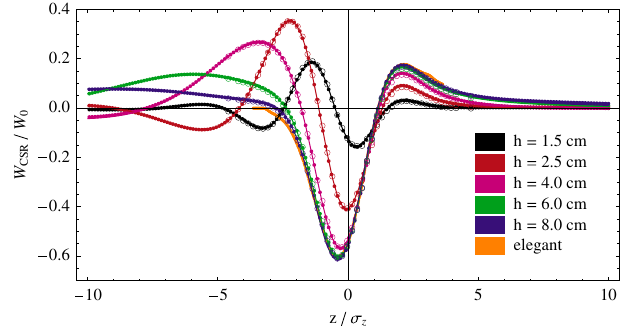
FIG. 8. (Color) The steady state using parameter set A for varying chamber heights h . The A&Y code (dots), Bmad (circles), and the CSR-wake formula Eq. (53) (lines) agree well, and ELEGANT agrees with the data at large chamber